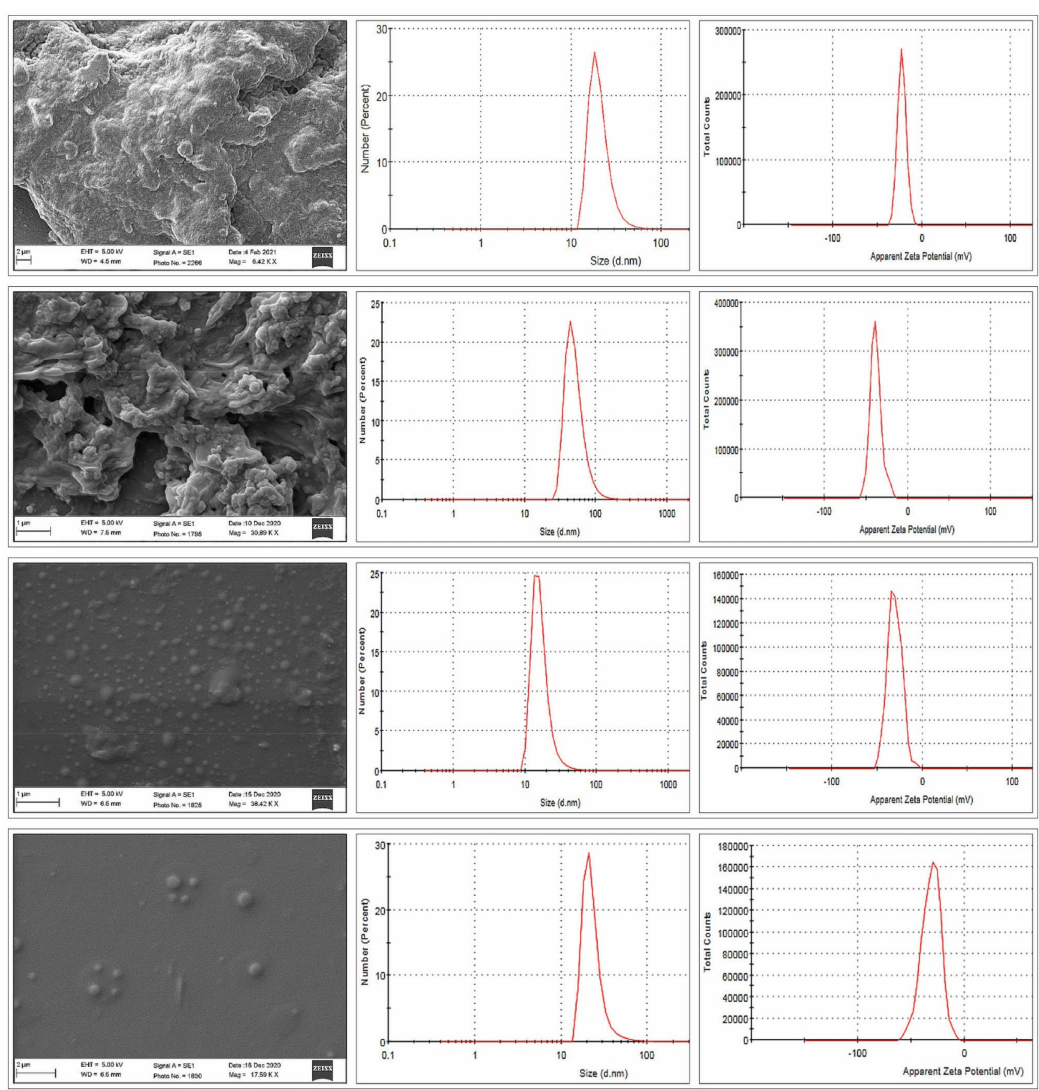
Figure 3. SEM (obtained by the second method), size and zeta potential of STIN ( first from top ) (size = 78.98 d.nm, ZP = − 28.0 mV), S2TIN ( second from top ) (size = 94.28 d.nm, ZP = − 38.2 mV), TSIN ( third from top ) (size = 88.65 d.nm, ZP = − 30.5 mV), and T2SIN ( bottom ) (size = 91.11 d.nm, ZP = − 34.1 mV) ( n =